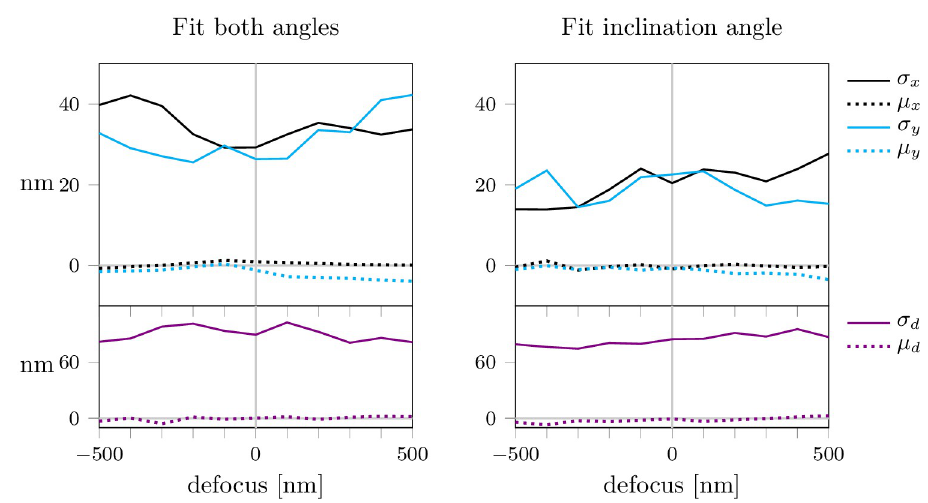
Fig 3. Fitting dipole orientation with astigmatism. We fitted the lateral position ( x , y ), defocus d and dipole orientation in the presence of astigmatism. In panel (a) we fitted both the inclination and azimuthal angle ( θ , ϕ ). In panel (b) we assumed the azimuthal angle ϕ to be known and fitted the inclination angle θ only. Each data point represents 5000 simulations. For each simulation, the ground truth dipole orientation was chosen randomly. Background noise was set to b = 100.